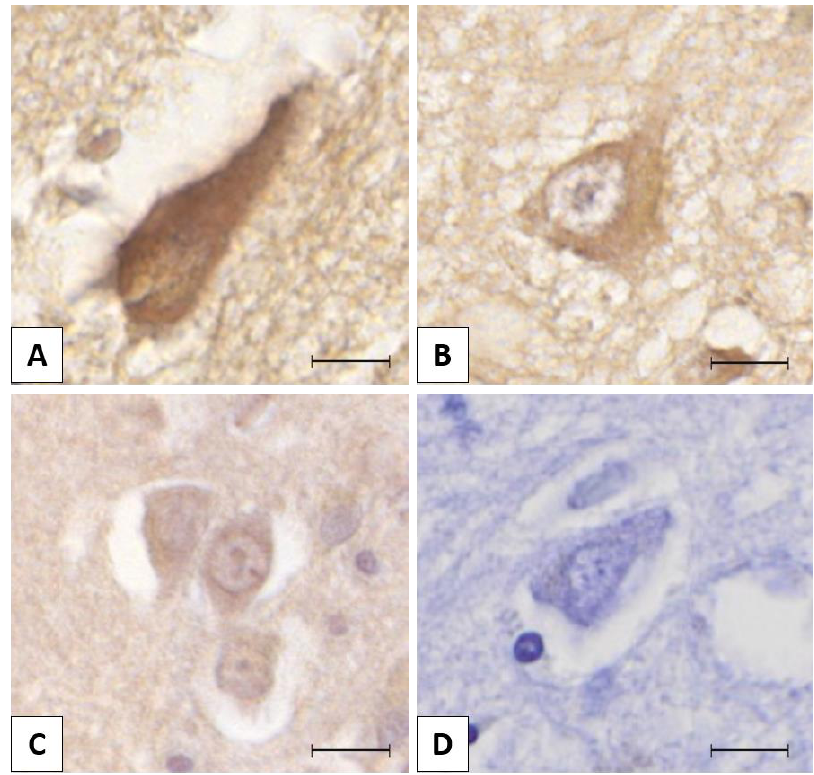
Figure 1. The figure presents different lemur tyrosine kinase 2 (LMTK2) immunolabelling intensities in neurons: ( A ) strong positivity (3+); ( B ) moderate positivity (2+); ( C ) mild positivity (1+); ( D ) negative (0). The protein was visualized by 3,3′ -diaminobenzidine (DAB) chromogen. Nuclear counterstain with hematoxylin. Scale bar: 10 µm.